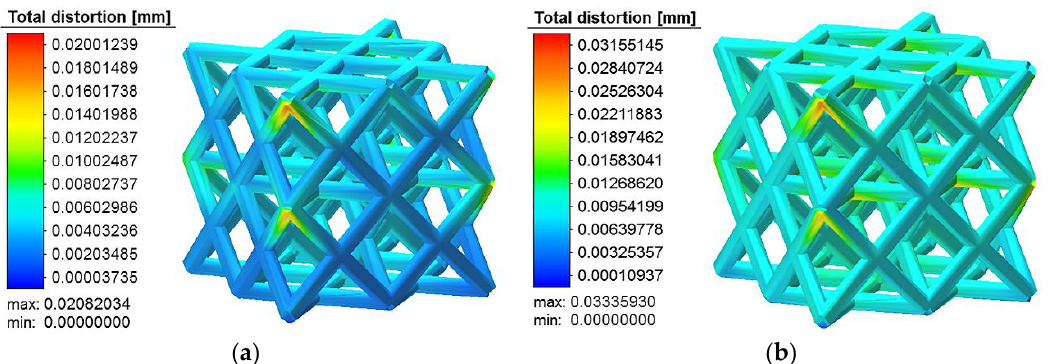
Figure 13. Deformation position of the FCC structure at different energy densities: ( a ) ω = 41.7 J/mm 3 , ( b ) ω = 111.1 J/mm 3 .